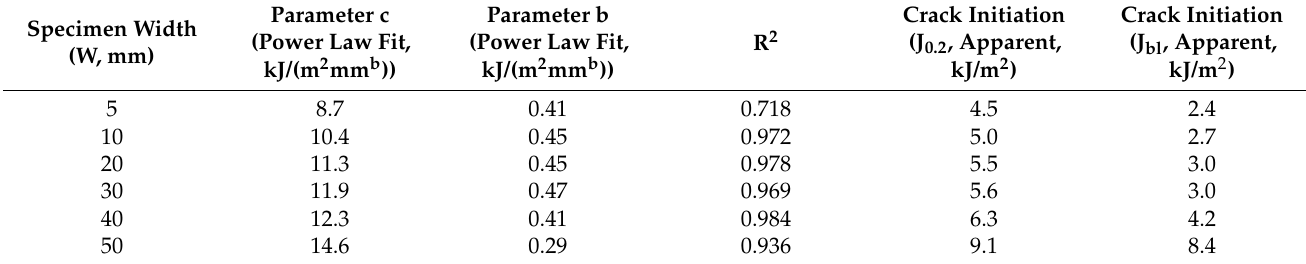
Table 3. Power law fitting parameter (c and b according to Equation (11)) of the J–R curve with the corresponding statistical coefficient, R 2 , and initiation toughness value, J 0.2 , for increasing specimen sizes (W of 5, 10, 20, 30, 40 and 50 mm) of ABS specimens as determined following the ESIS TC 4 multispecimen